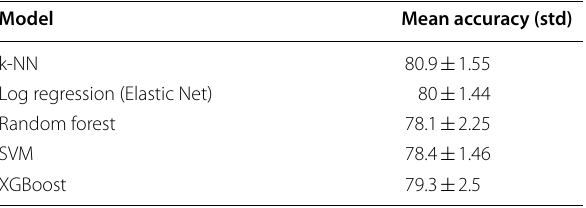
Table 4 Models’ performance on average, after 100 nested cross-validation